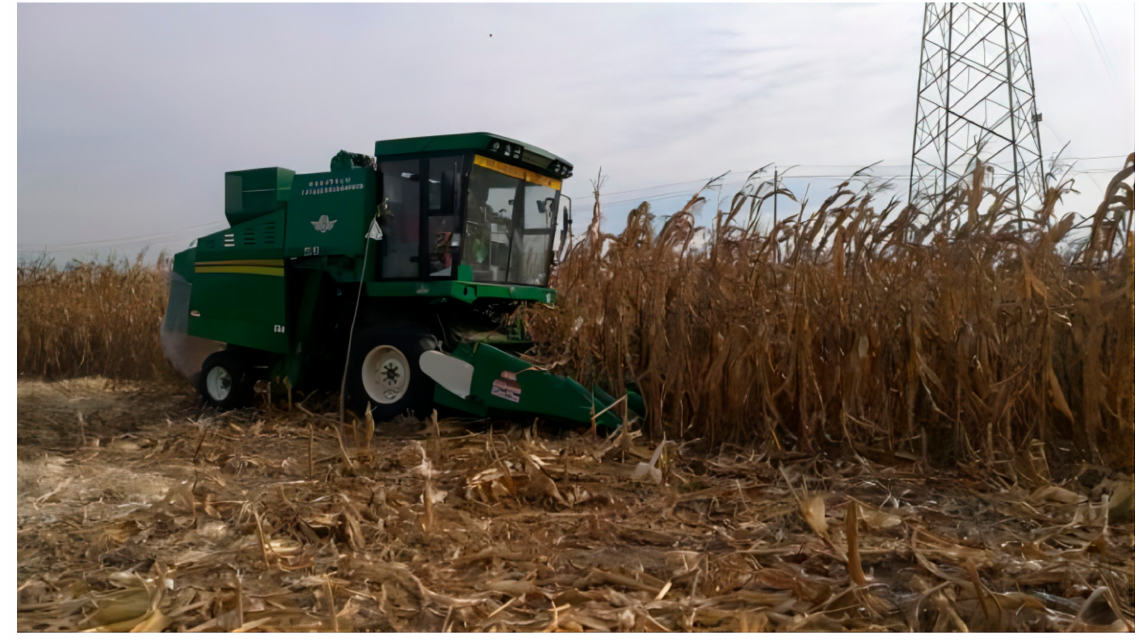
Figure 9. Field test